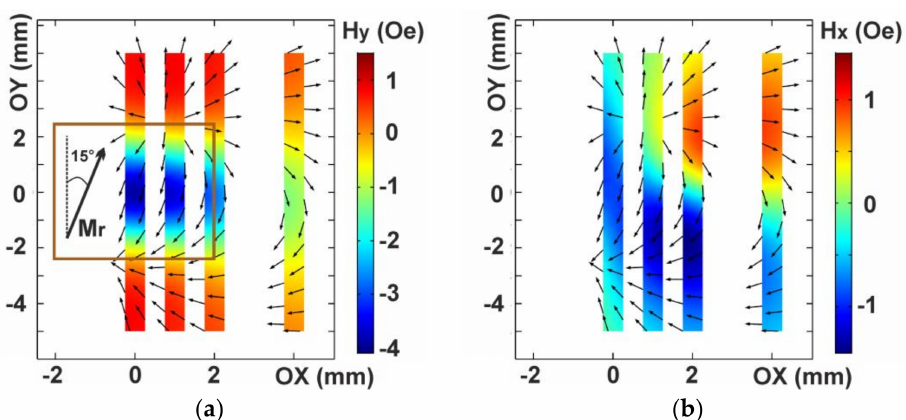
Figure 9. Stray magnetic field distribution on the surface of the GMI element at the different positions of the magnetic insert, the magnetic insert magnetization is directed at an angle 15 ◦ related to the OY axis: Hy stray magnetic field component along the long side of the GMI element ( a ); Hx stray magnetic field component along the short side of the GMI element ( b ). Mr —the magnetic insert magnetization direction in the XY